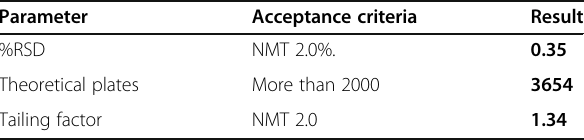
Table 7 Analytical data of system suitability